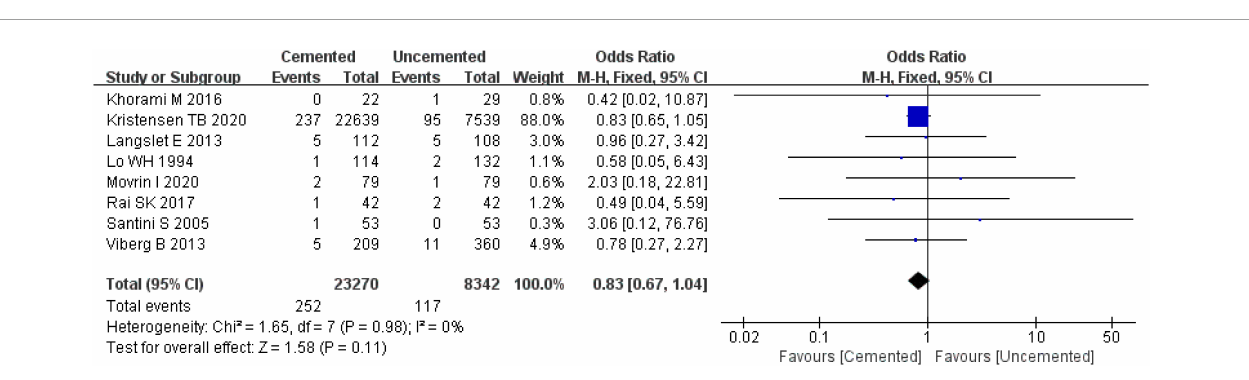
FIGURE11 Forest plot for comparison of prosthesis dislocations between cemented bipolar hemiarthroplasty (CBH) group and uncemented bipolar hemiarthroplasty (UCBH) group.